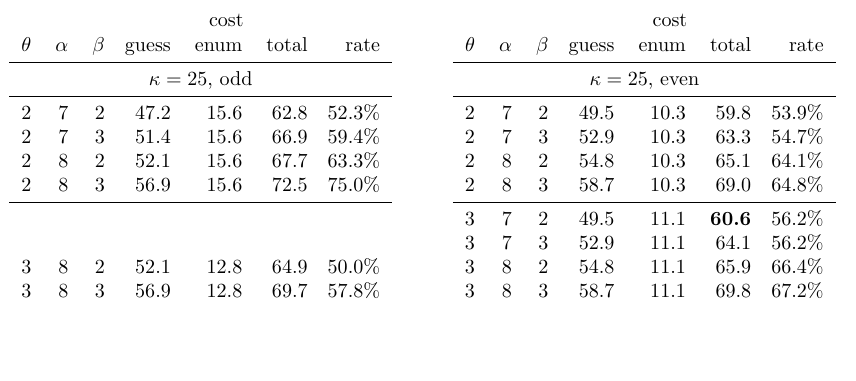
Table 14: Experimental results for New Hope parameters and κ = 25. For details see Table 12.